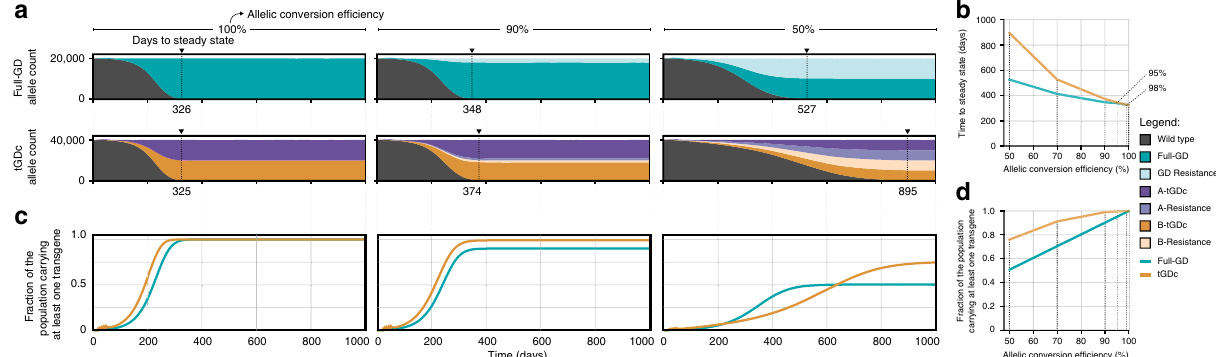
Fig. 6 Comparison of full-drive and tGD spread in modeled populations. Model predictions for releases of Ae. aegypti mosquitoes homozygous for the tGD and full-drive systems, parameterized with ballpark estimates: (i) a cleavage frequency of 100% in females and males, (ii) an allelic conversion ef fi ciency, given cleavage, of 50 – 100% in females and males, and (iii) no fi tness costs associated with the Cas9 or gRNA alleles. All resistant alleles are assumed to be in-frame/cost-free. Five weekly releases are simulated, consisting of 100 adult males homozygous for each system, into a population having an equilibrium size of 10,000 adults. Model predictions were computed using 50 realizations of the stochastic implementation of the MGDrivE simulation framework. a Stacked allele counts over time for the full-drive and tGD systems for allelic conversion ef fi ciencies of 100, 90, and 50%. b Allelic conversion ef fi ciency plotted against time to steady state for the full-drive (turquoise) and tGD (yellow) systems. c Fraction of the population carrying at least one transgene over time for the full-drive (turquoise) and tGD (yellow) systems for allelic conversion ef fi ciencies of 100, 90, and 50%. d Allelic conversion ef fi ciency plotted against the fraction of the population carrying at least one transgene at equilibrium for the full-drive (turquoise) and tGD (yellow)